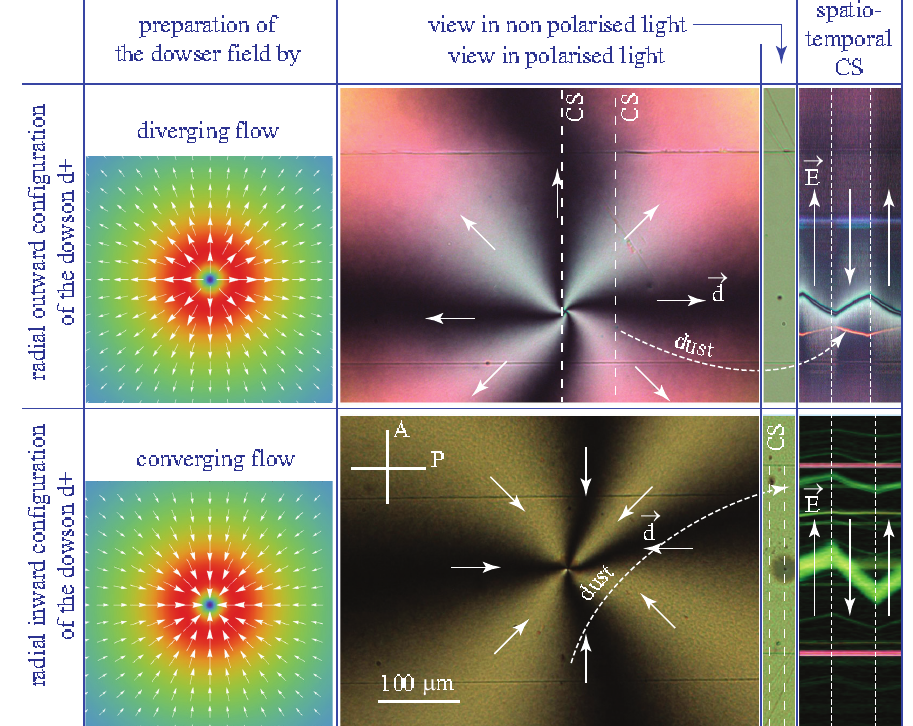
Figure 11. Electric field-induced motion of a dowsons d+. The radial outward and radial inward configurations of the dowson are generated by diverging and converging Poiseuille flows. For the same direction of the electric field, the direction of motion of dowson is opposite for the outward and inward configurations. The motion of the dust particles is due to electro-osmotic flows. (MBBA)